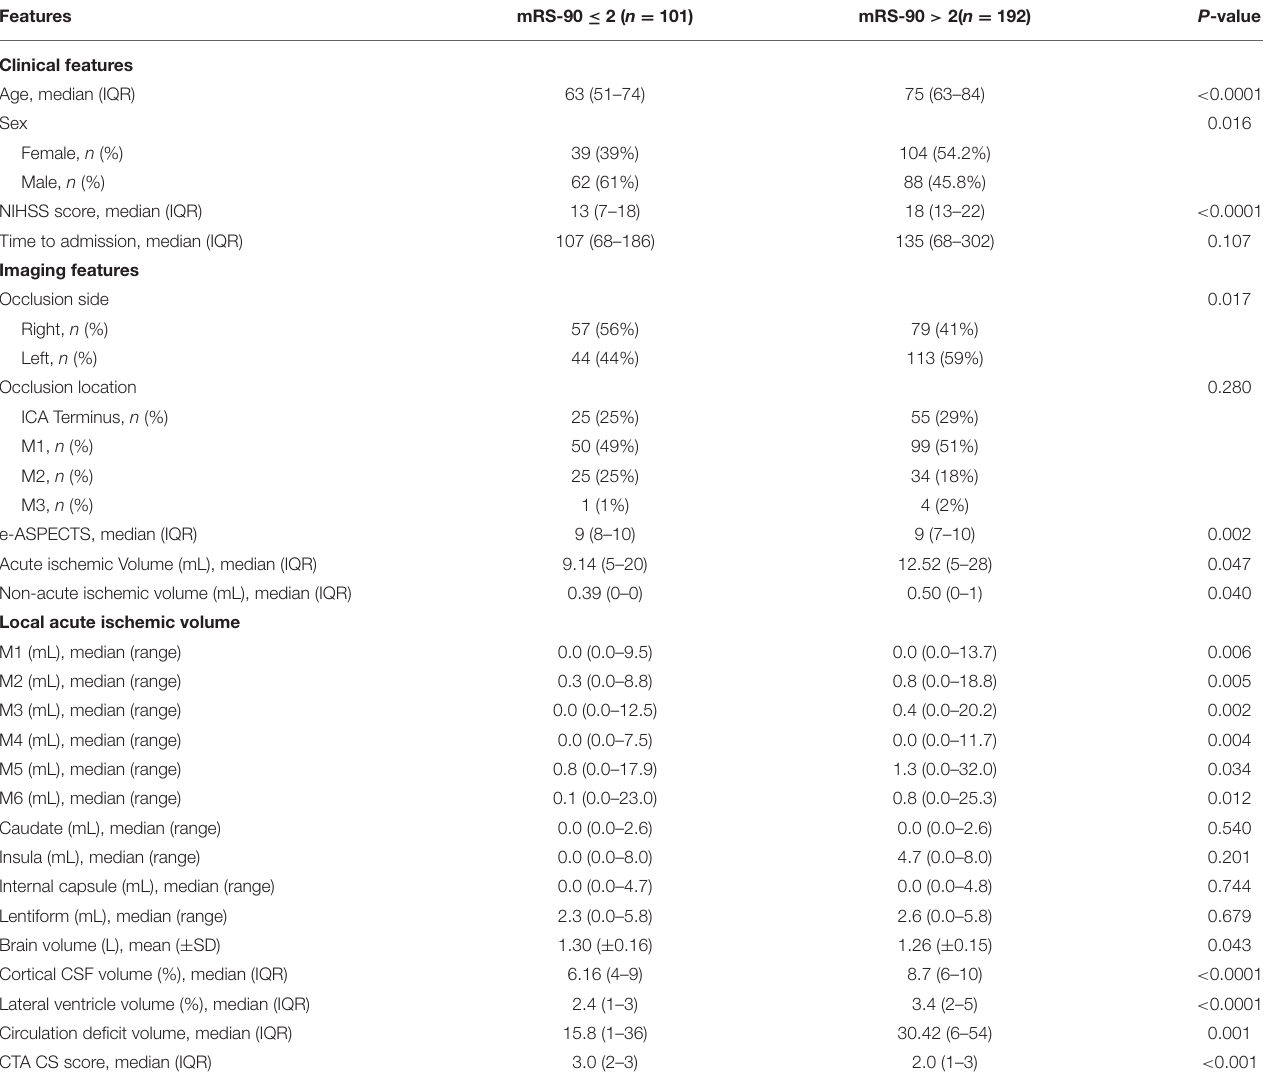
TABLE 1 | Statistical feature comparison between the two outcome groups.